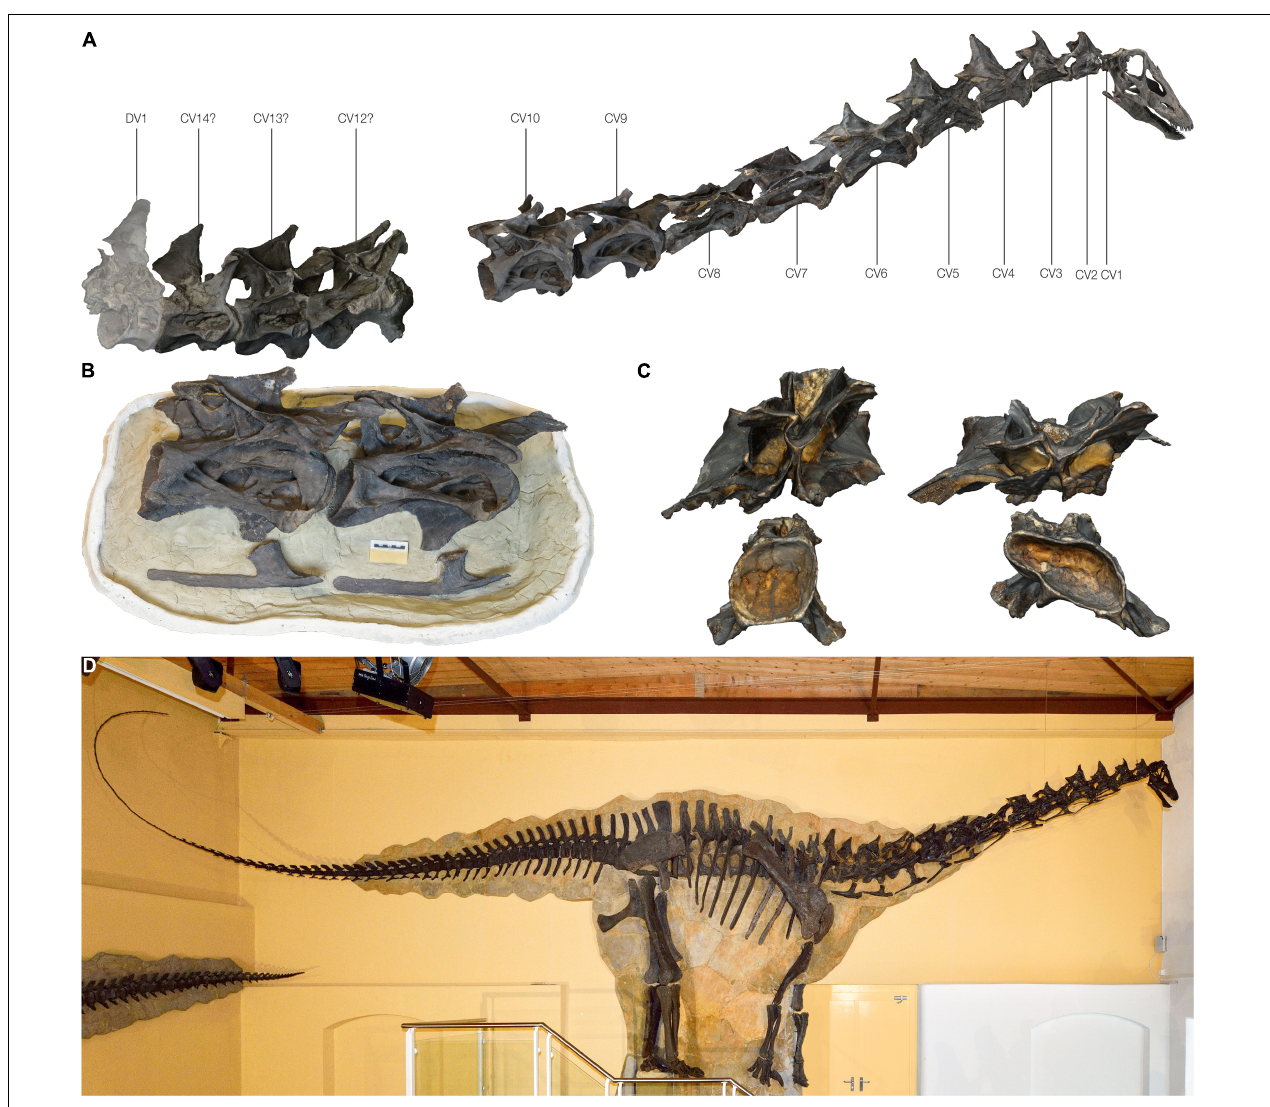
FIGURE 1 | The Galeamopus pabsti specimen SMA 0011/NMZ 1000011 used in this study. (A) Articulated cervical series based on the 3D scanned bones; note the gap between the last three cervical vertebrae and CV 10. (B) Photogrammetric model of the partially exposed CV 9 and CV 10. (C) Disarticulated centra and neural arches of CV 7 (left) and CV 8 (right) in posterior view. (D) Mounted skeleton of Galeamopus pabsti at the Sauriermuseum Aathal (SMA) in Aathal,